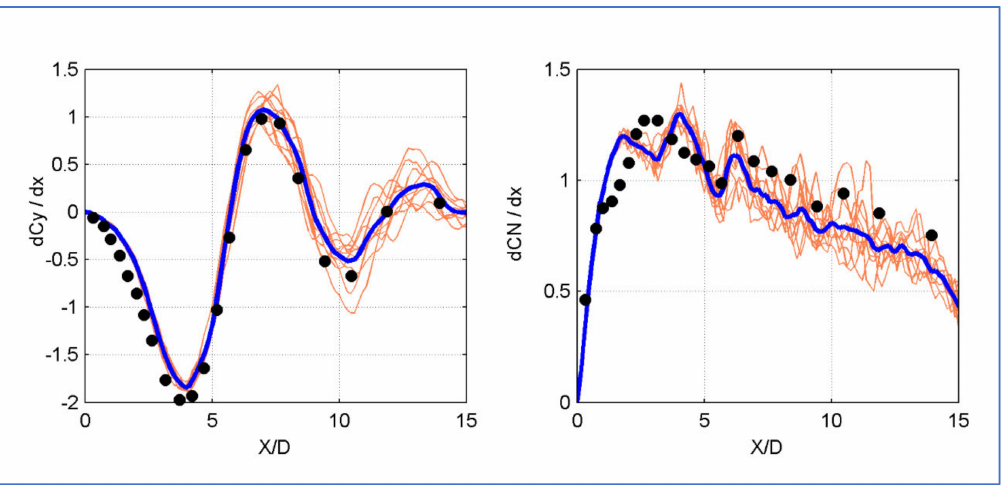
Figure 15. Local side and normal force coefficients at Mach number Ma = 0.2, Reynolds number Re = 2 × 10 6 and angle of attack α = 45 degrees within a period of T = 0.5 s compared to experimental data (black dots). Grid